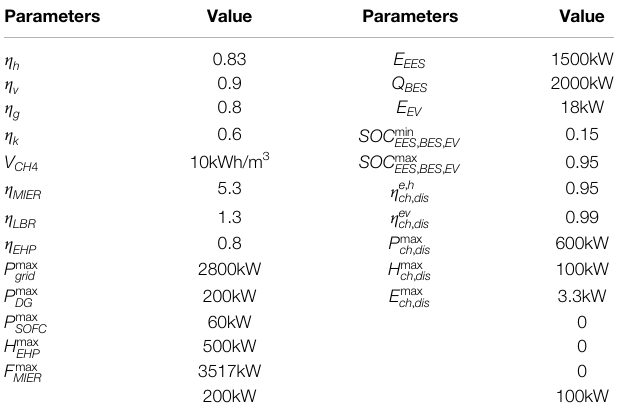
TABLE 2 | Technical parameters of MEG system.